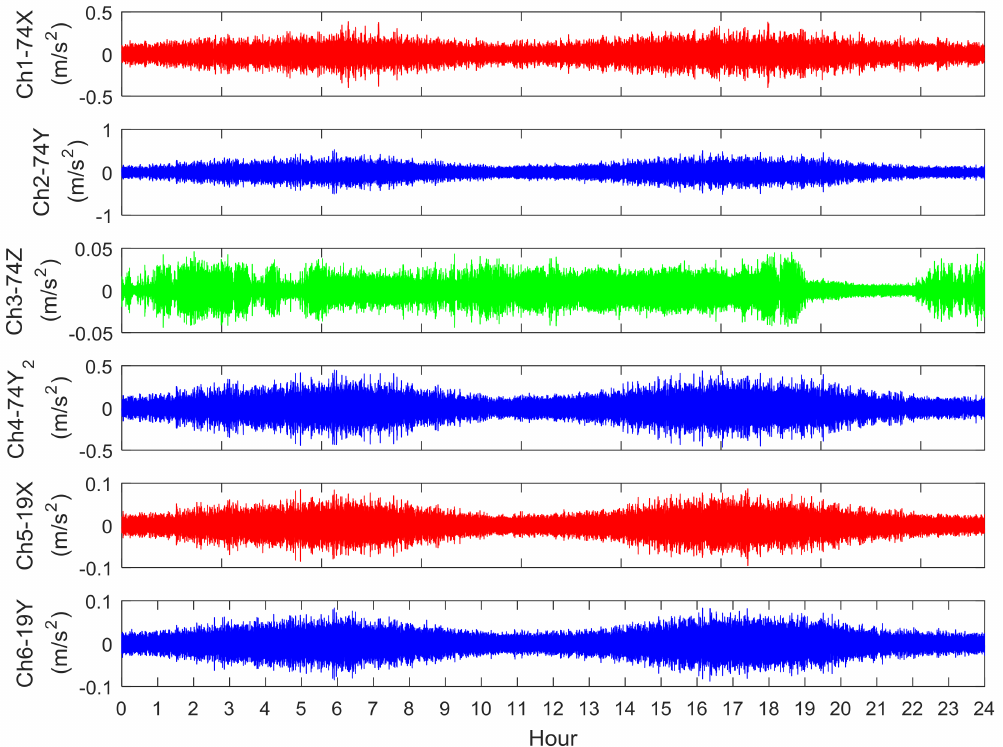
Figure 6. Time-series of acceleration data on 2 June